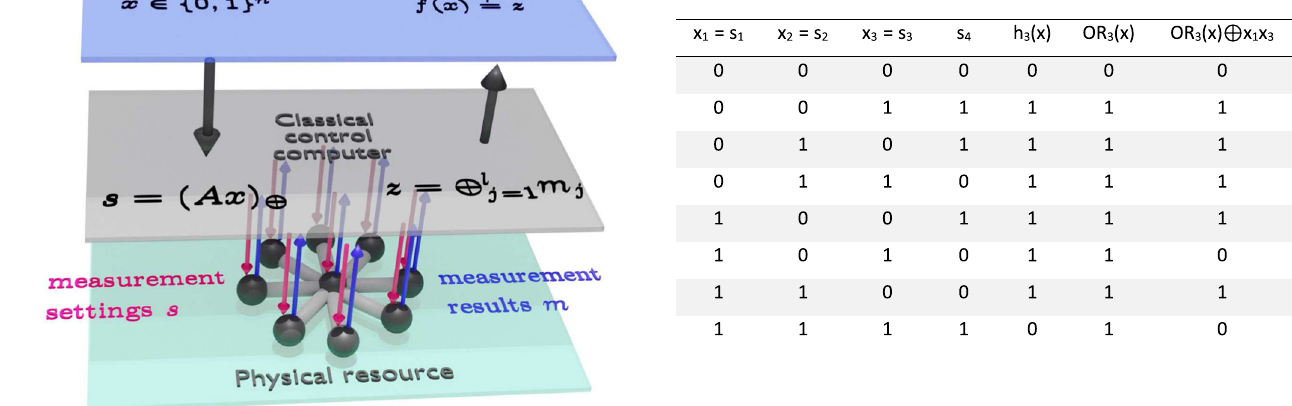
L l m j is generated by the parity of the outcomes from the quantum j ¼ 1